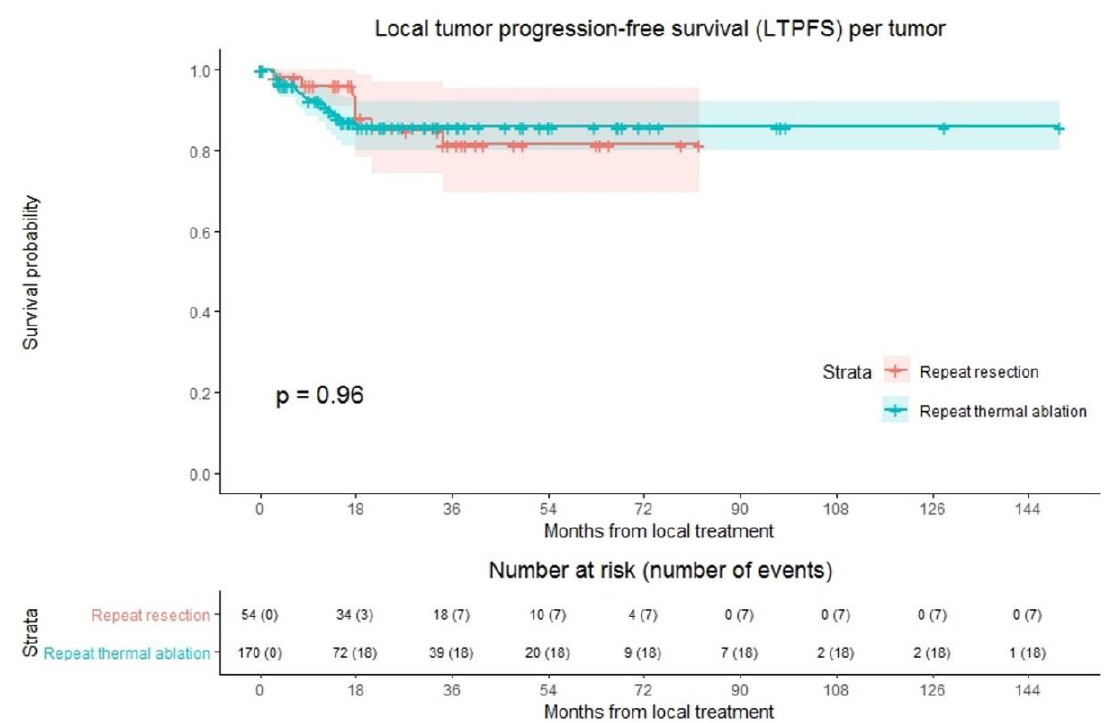
Figure 2. Kaplan–Meier curves of local tumor progression-free survival (LTPFS) per tumor after repeat resection (red) and repeat thermal ablation (green). Numbers at risk (number of events) are per tumor. Overall comparison log-rank (Mantel-Cox) test, p = 0.959. Death without local tumor progression (LTP; competing risk) is censored.